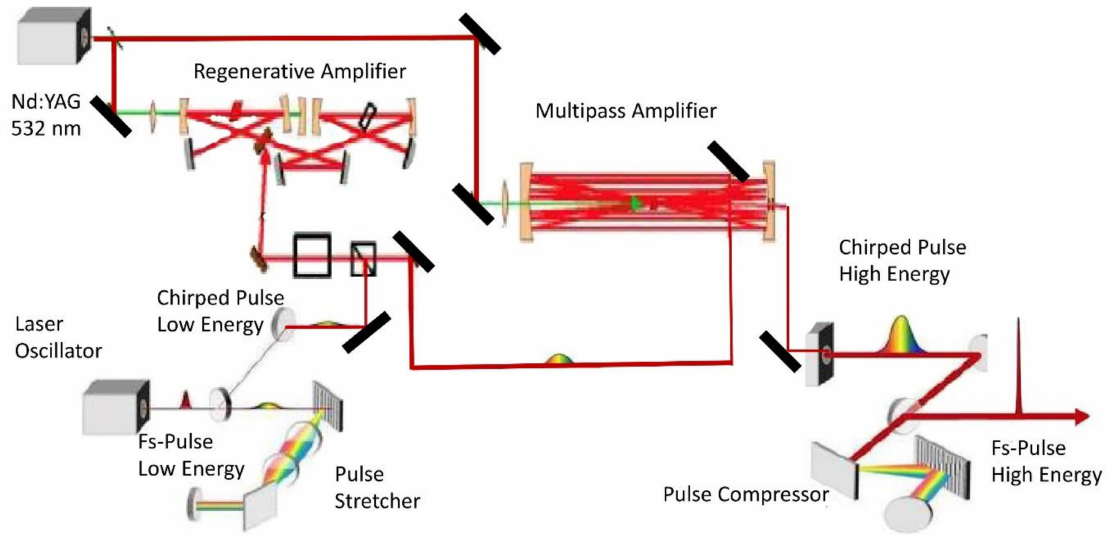
Figure 3. Functional schematic diagram of an fs-laser system used typically in fs-LIMS (see text for more